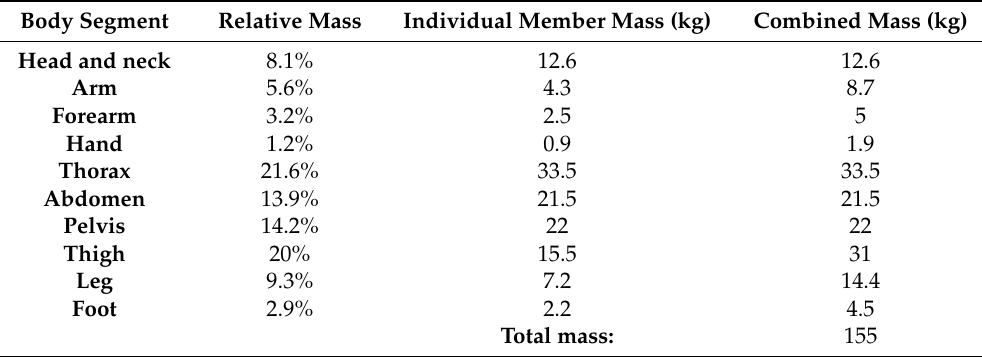
Table 2. Human body mass distribution.